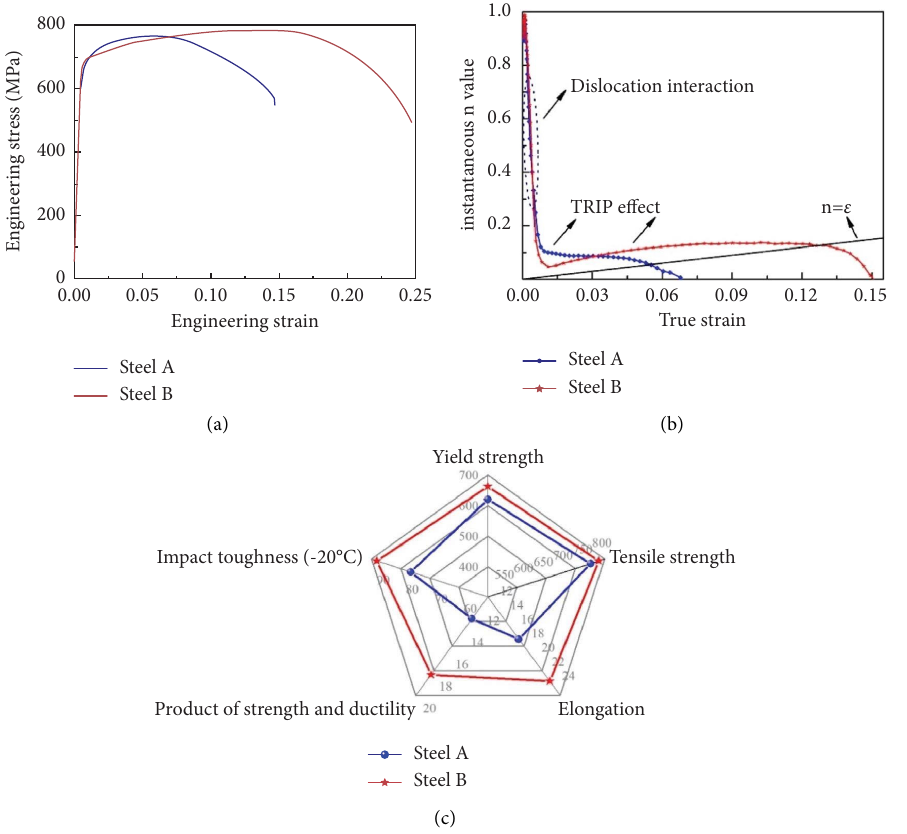
Figure 6: Mechanical properties and work hardening behavior: (a) engineering stress-engineering strain curves; (b) instantaneous work hardening exponent as a function of true strain; and (c) comparison of mechanical properties between steel A and steel